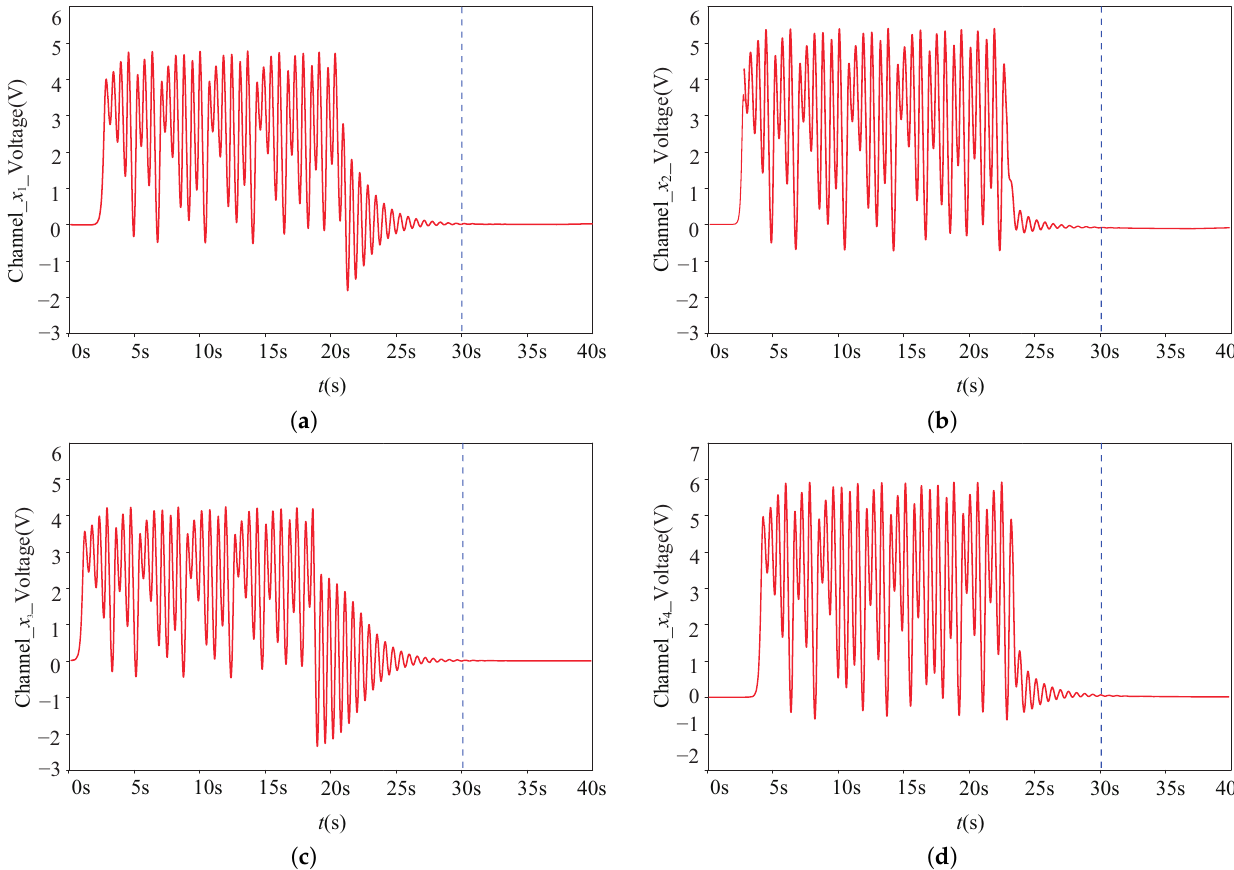
(cid:87) (cid:11)(cid:86)(cid:12) Figure 19. Time-domain waveforms of state variables of the system (28). ( a ) t plane; ( c ) t x 3 plane; ( d ) t x 4 plane. − − − − According to the circuit experiment results of the time-domain waveform diagram of state variables (time responses of error system) in Figure 19, it can be found that its trajectory asymptotically converges to the origin by adding a feedback controller, which shows the control effect of the designed controller.